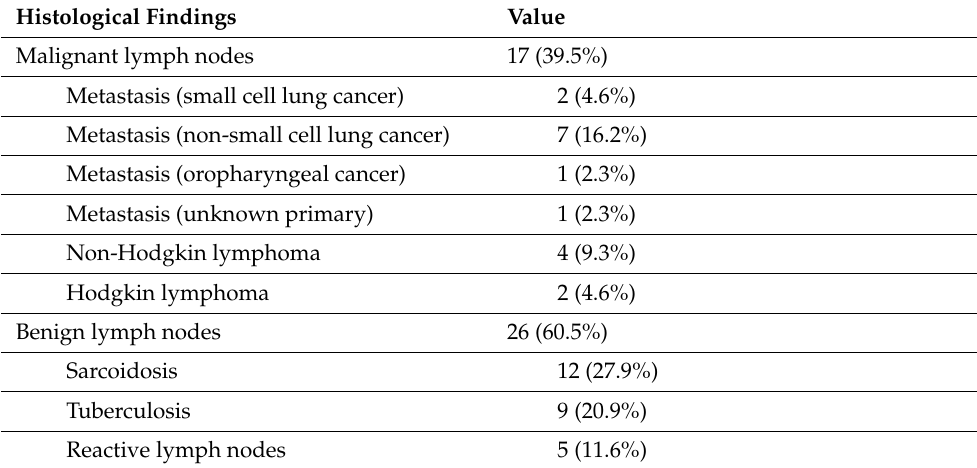
Table 1. Histological characteristics of evaluated lymph nodes. Histological